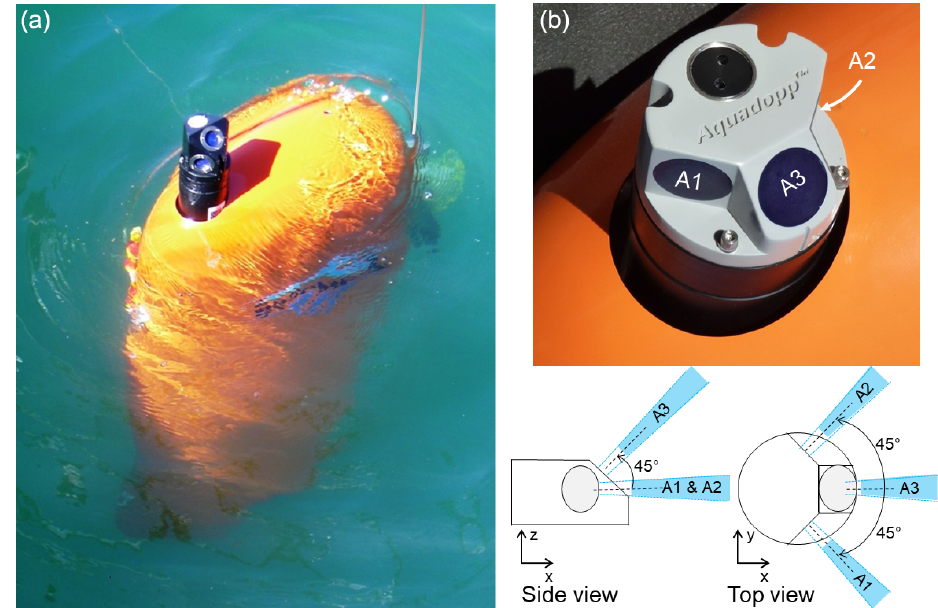
Figure 1. The moored Aqualog automatic mobile profiler with a deep-water Aquadopp acoustic Doppler current meter (a) . Transducer head of the shallow-water Aquadopp acoustic Doppler current meter on the Aqualog profiler (b) . Bottom right: the acoustic beams are shown in blue and are labeled A 1 , A 2 , and A 3